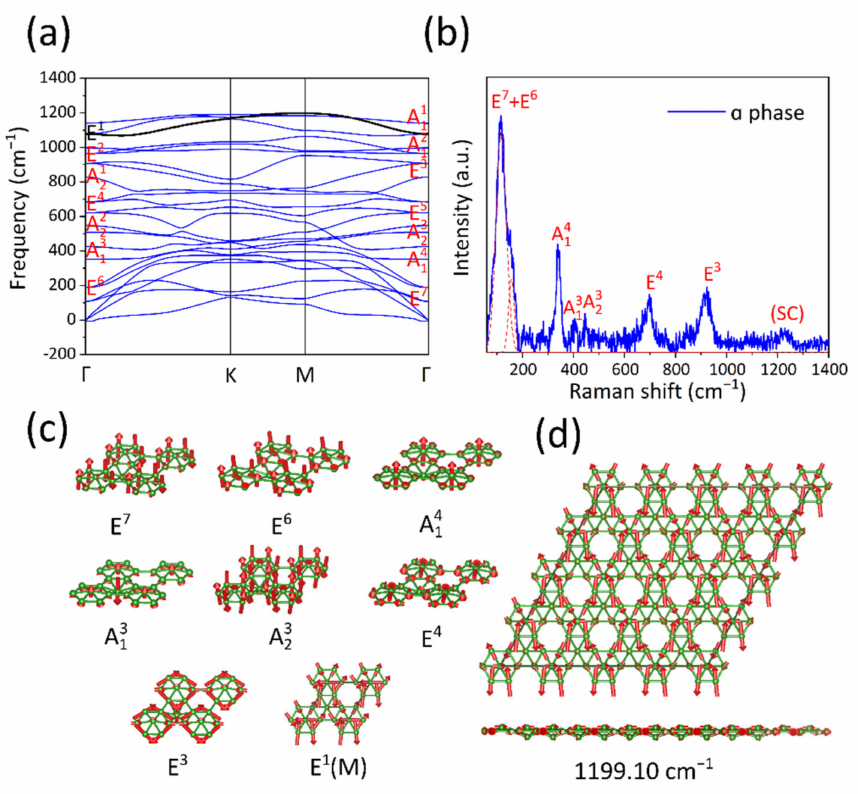
Figure 3. ( a ) The calculated phonon dispersion curves of asymmetric buckled α phase. ( b ) The near-field TERS signal of α phase, E 7 and E 6 peaks are fitted by red dashed curve. ( c ) Vibration modes of unit cell associated with TERS peaks. ( d ) The vibration mode of supercell associated with the 1230 cm − 1 peak in